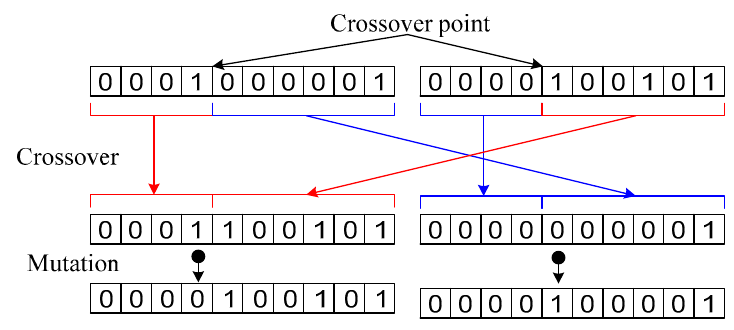
Figure 2. Crossover and mutation operations.